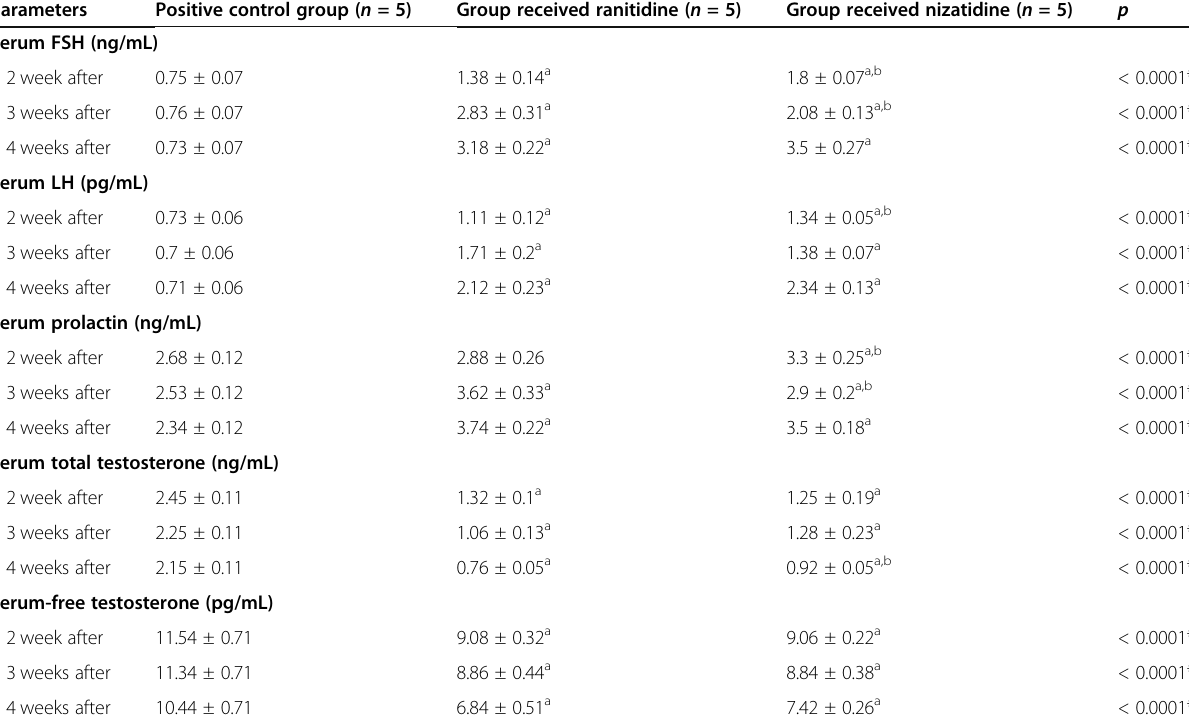
Table 2 Effects of oral administration of nizatidine, ranitidine (27 mg/kg b. wt.) on serum hormones of male albino rats